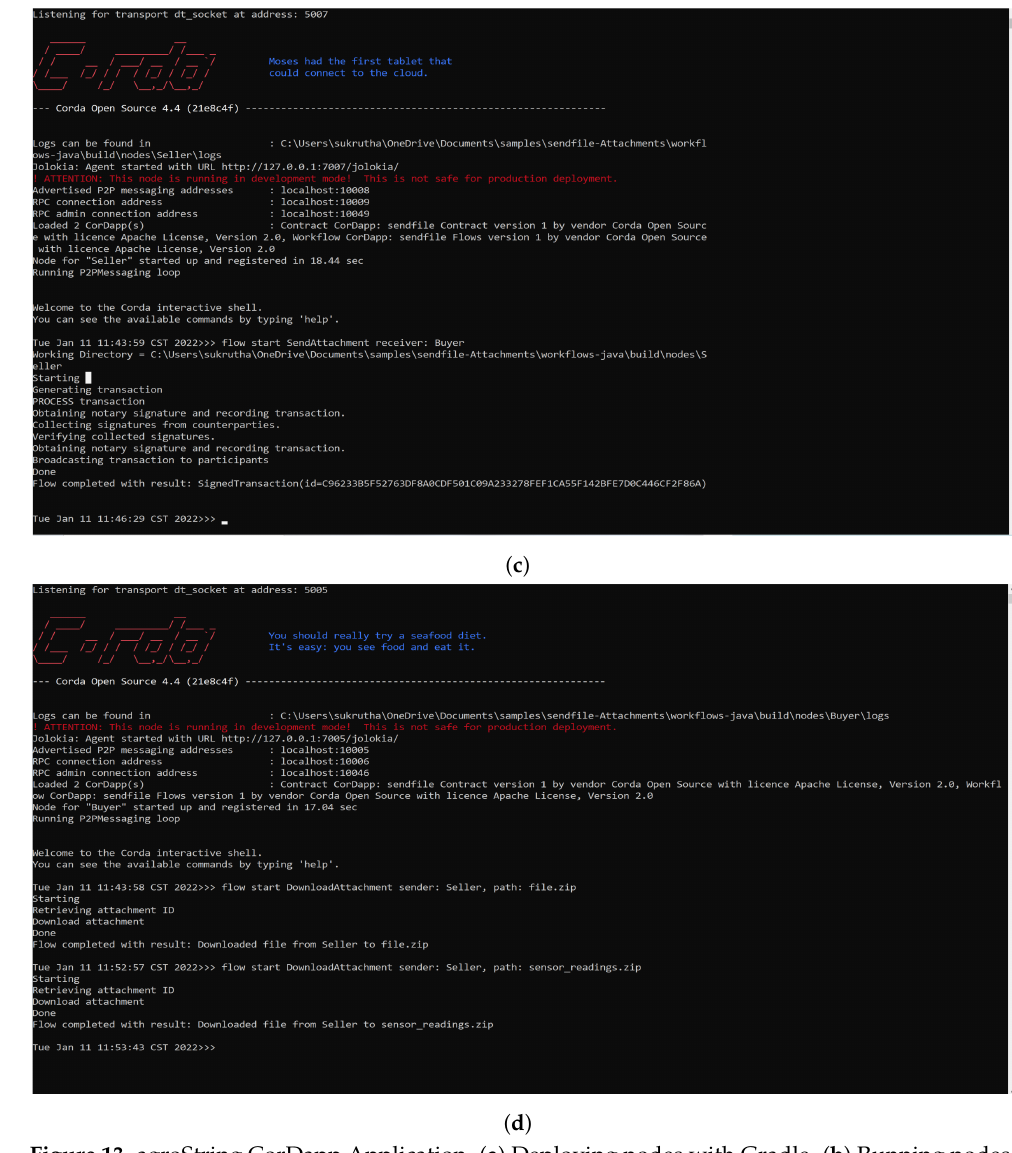
Figure 13. agroString CorDapp Application. ( a ) Deploying nodes with Gradle. ( b ) Running nodes. ( c ) Flows start for attachment of file. ( d ) Retrieving the